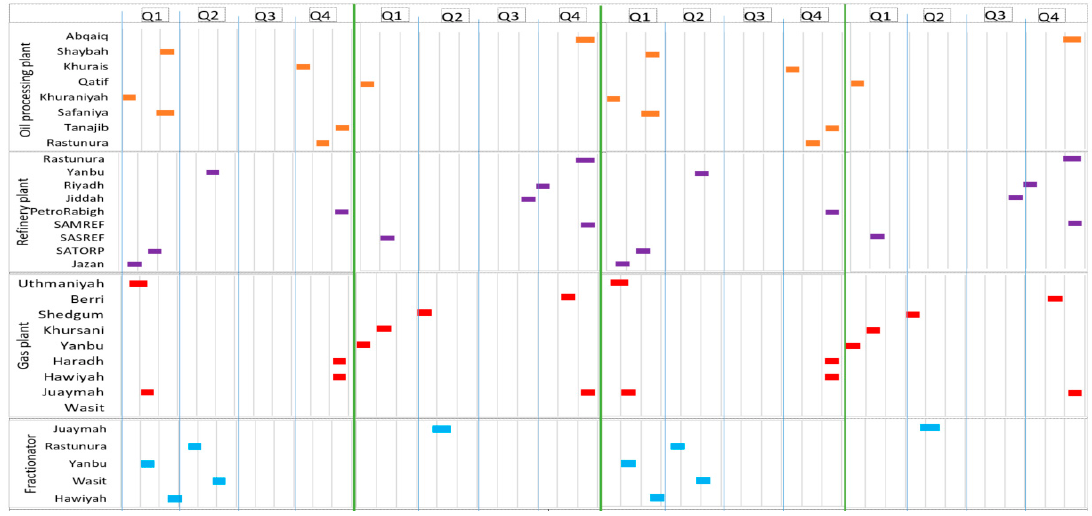
Figure 4. Maintenance schedule for all hydrocarbon supply chain (HCSC) plants (operations and maintenance model); Color code: Orange: oil processing plants; Purple: Refinery plants; Red: Gas plants; Light Blue: Fractionator